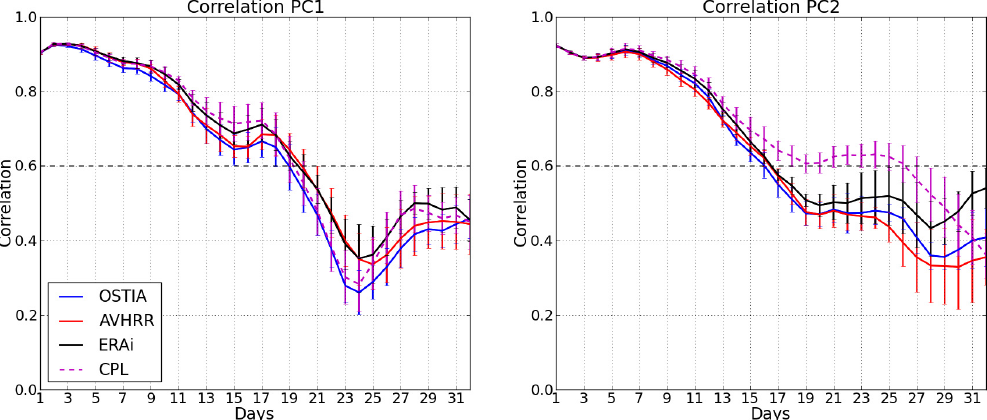
Fig. 9. Same as Fig. 5 for the experiments conducted over 22 winters from 1985 to 2006: OSTIA, AVHRR and ERAi experiments are the blue, red and black lines, respectively. For comparative purposes, the coupled experiment is plotted in dashed